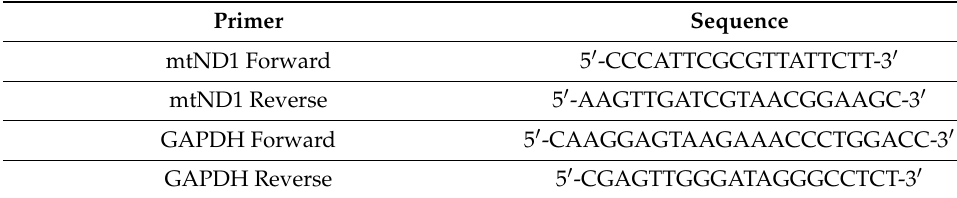
Table 1. Genomic and mitochondrial primer